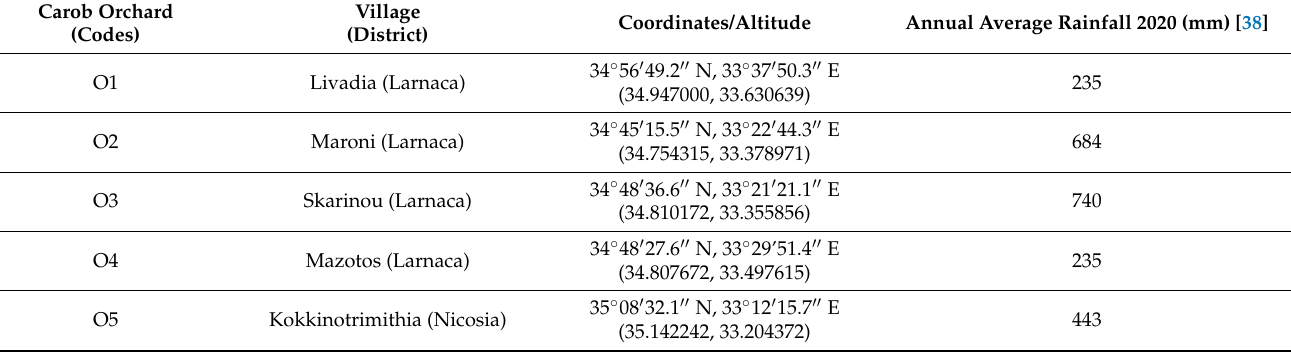
Table 3. Geographical locations of carob